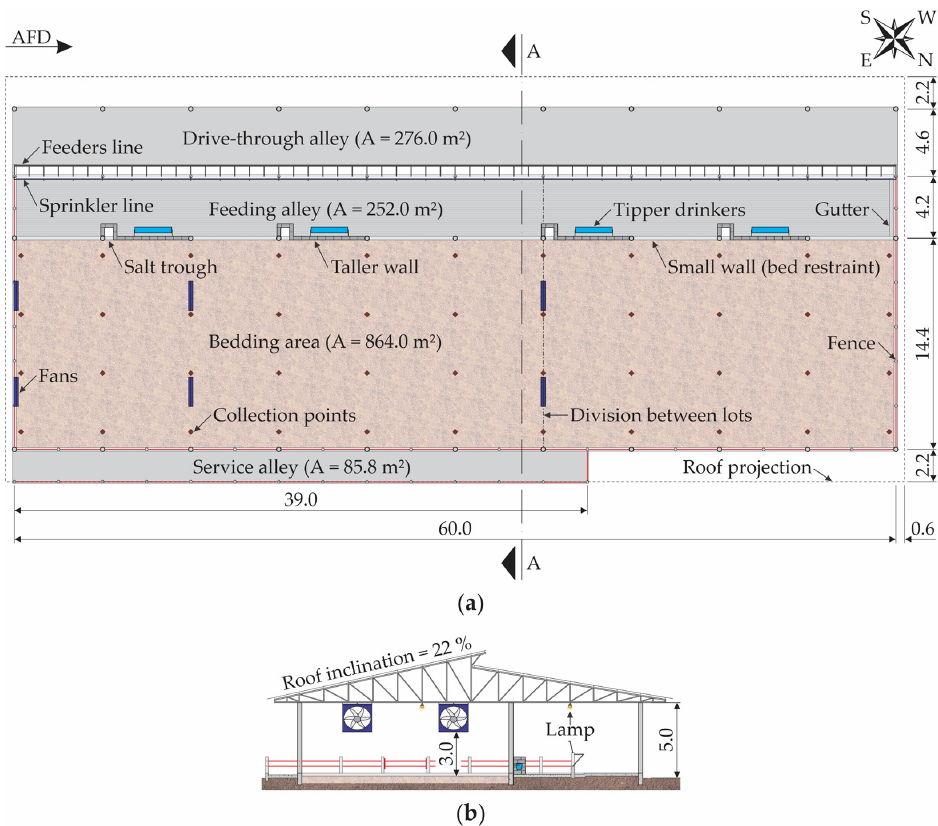
Figure 1. Schematic representation of the compost-bedded pack barn system where the data were collected: floor plan with collection points ( a ) and cross-sectional AA ( b ). AFD—air-flow direction; dimensions in meters (m); Source: Oliveira et al. [19].